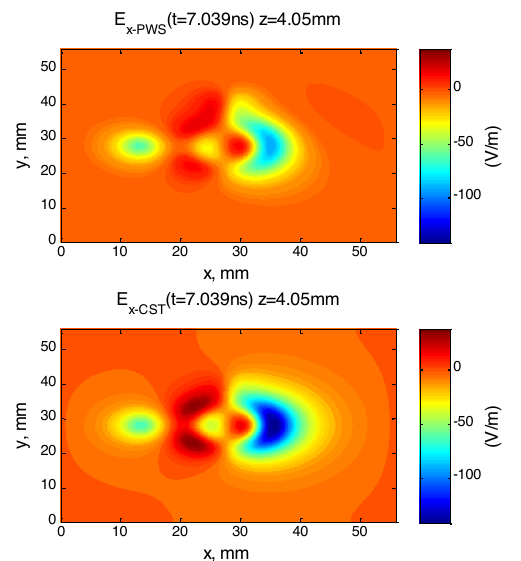
Figure 15: Comparison of E CST simulation and the proposed computation method.